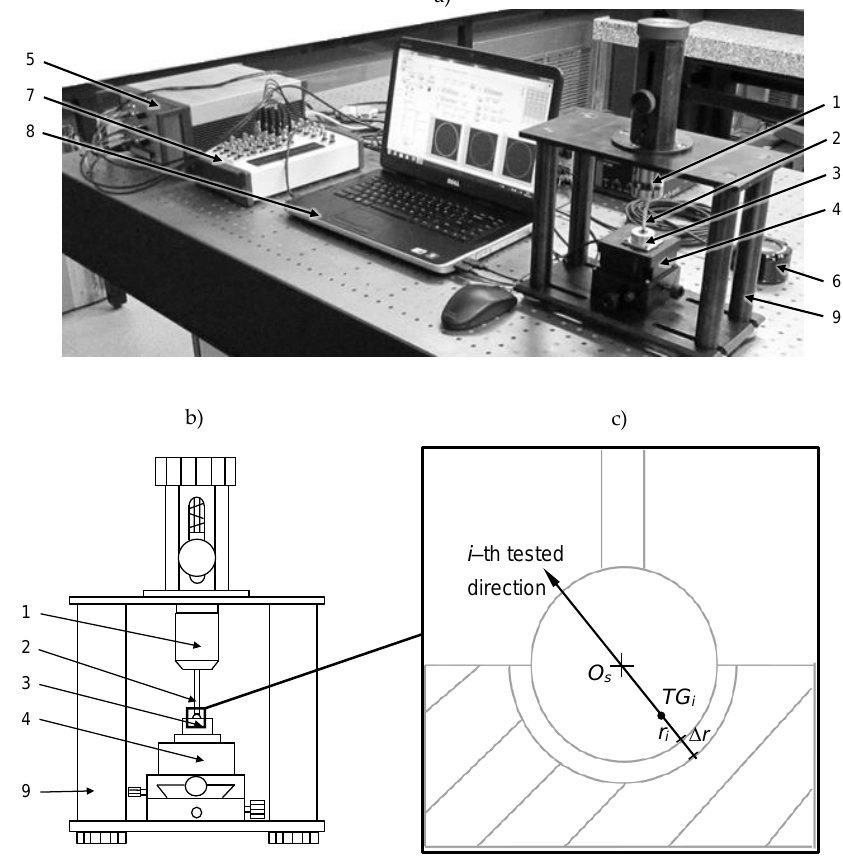
Figure 1. Setup for probe testing: ( a ) view, ( b ) scheme of the mechanical unit of the setup, and ( c ) detail—stylus tip placed inside of the inner hemisphere master artefact: 1—tested probe, 2—stylus tip, 3—master artefact, 4—3-axial piezostage, 5—piezostage controller, 6—probe’s interface receiver, 7—DAQ card, 8—PC, 9—frame.